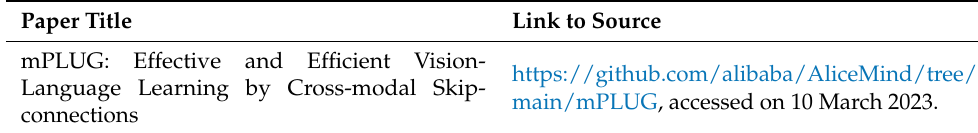
Table 11. Source code links for Description Generation.